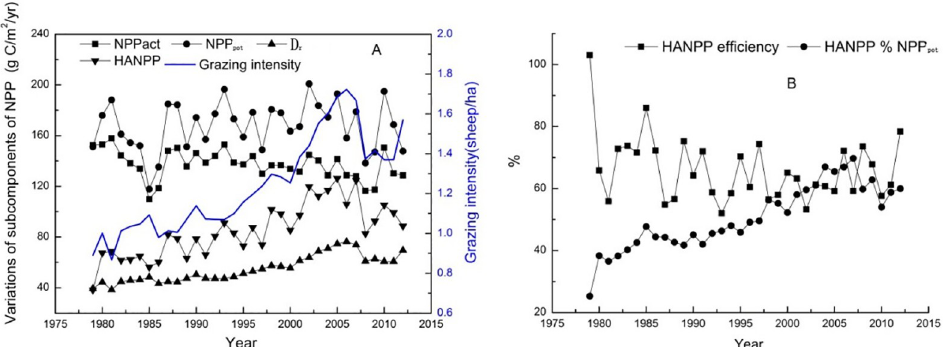
Fig 3. Interannual variations in subcomponents of NPP in the Xinjiang grasslands from 1979 to 2012.